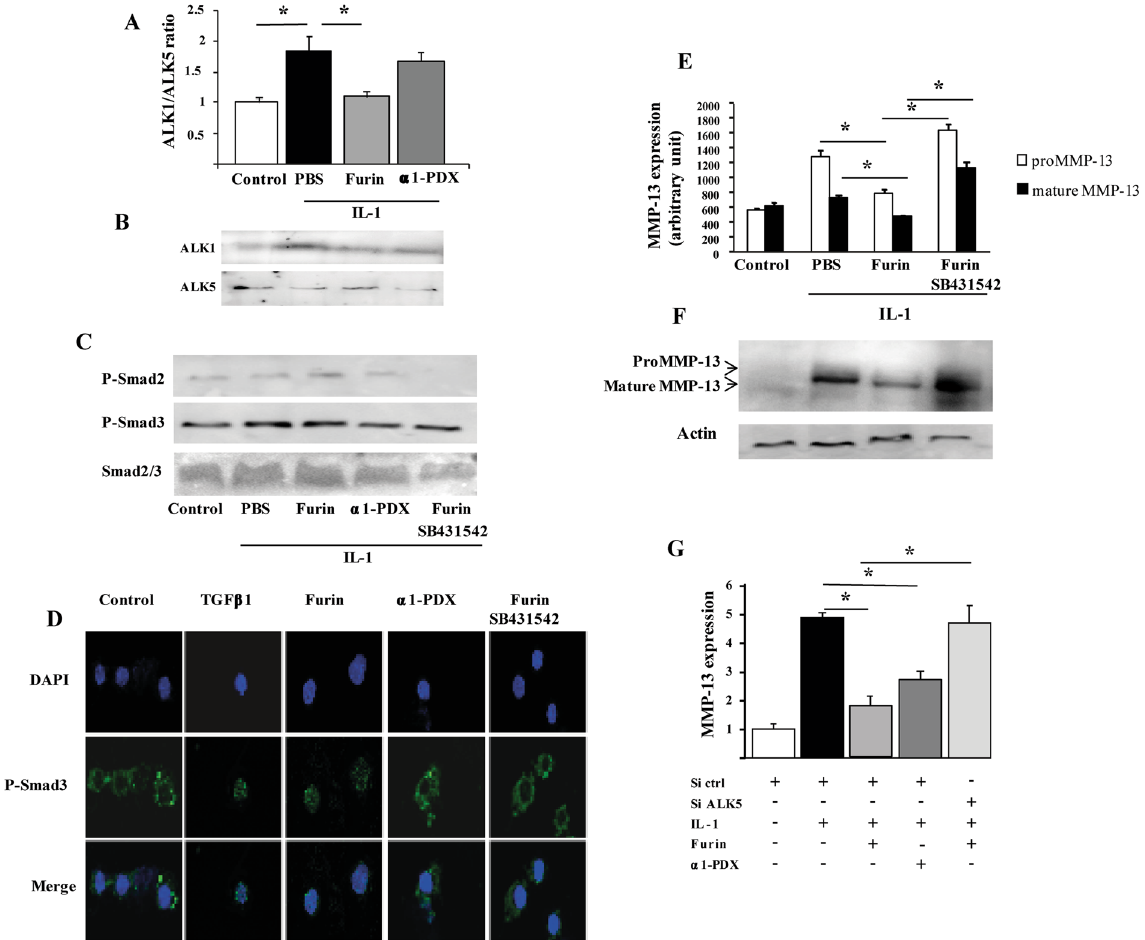
Figure 2. Furin activates ALK5/Smad3 signaling and reduces MMP-13 expression in primary chondrocytes. Primary chondrocytes were incubated with IL-1, and then cultured with PBS, Furin, α 1-PDX and Furin plus TGF β 1/ALK5 inhibitor SB431542. ( A ) Quantification of ALK1/ALK5 ratio (arbitraty units) as detected by Western blot. ( B ) Representative images of Western blot analysis of ALK1 and ALK5. ( C ) Western blot analysis of phosphorylation of Smad2, Smad3 and Smad2/3. ( D ) Immunocytochemistry of p-Smad3 translocation (X600). ( E ) Quantification of MMP-13 protein expression (proform and mature form) as detected by Western blot, actin being the loading control. ( F ) Representative images of Western blot analysis of pro and mature MMP-13 protein. ( G ) Quantitative RT-PCR analysis of MMP-13 mRNA expression in chondrocytes with or without Alk5 siRNA knockdown. Results are expressed as fold increase relative to controls. Data are mean ± SEM. * p <